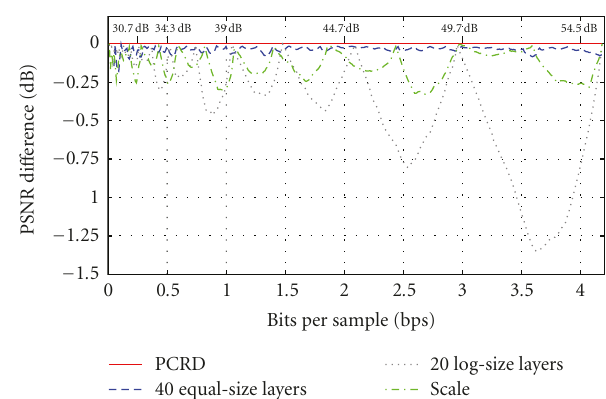
Figure 3: Coding performance evaluation between SCALE and two common allocation strategies distributing quality layers logarithmi- cally and uniformly spaced in terms of bitrate, for the portrait image (gray scaled, 8bps).